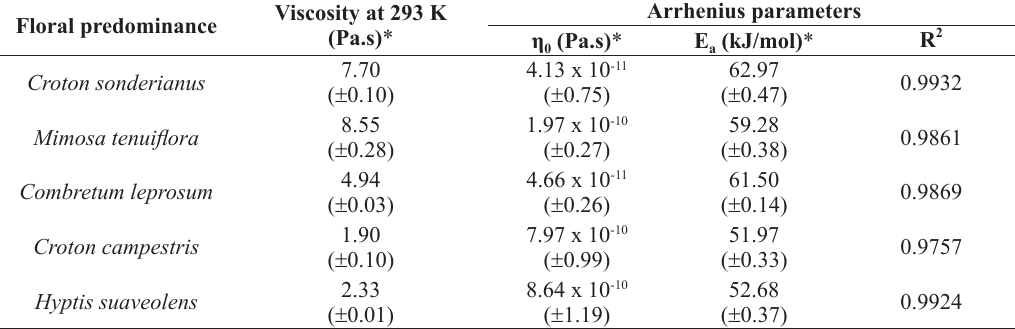
*average (standard deviation), n = 5.